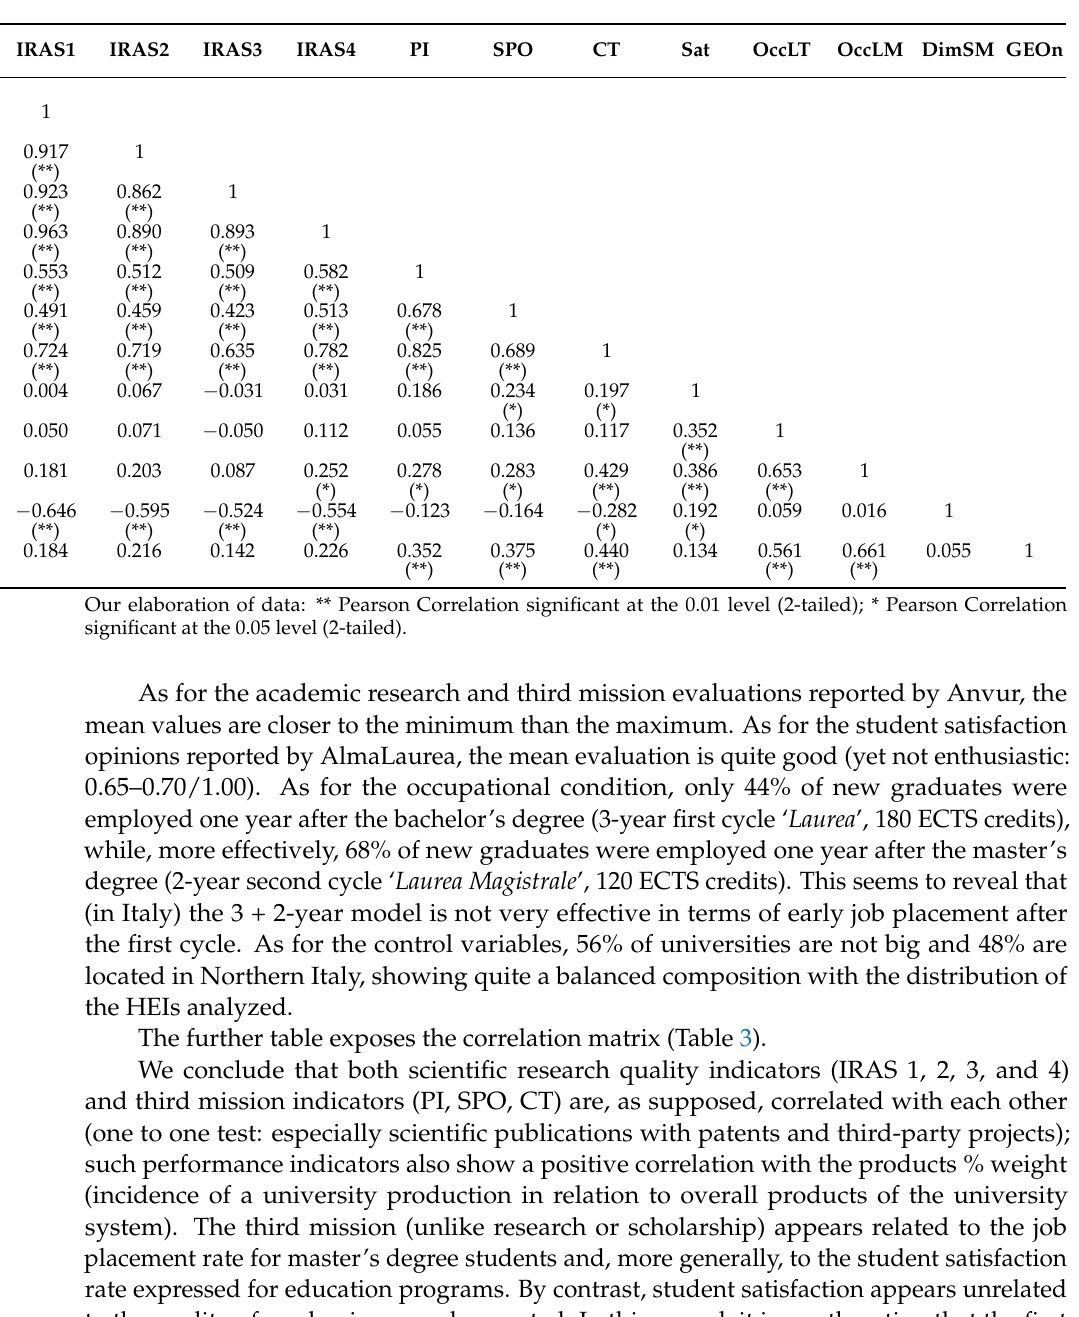
Table 3. Matrix pairwise